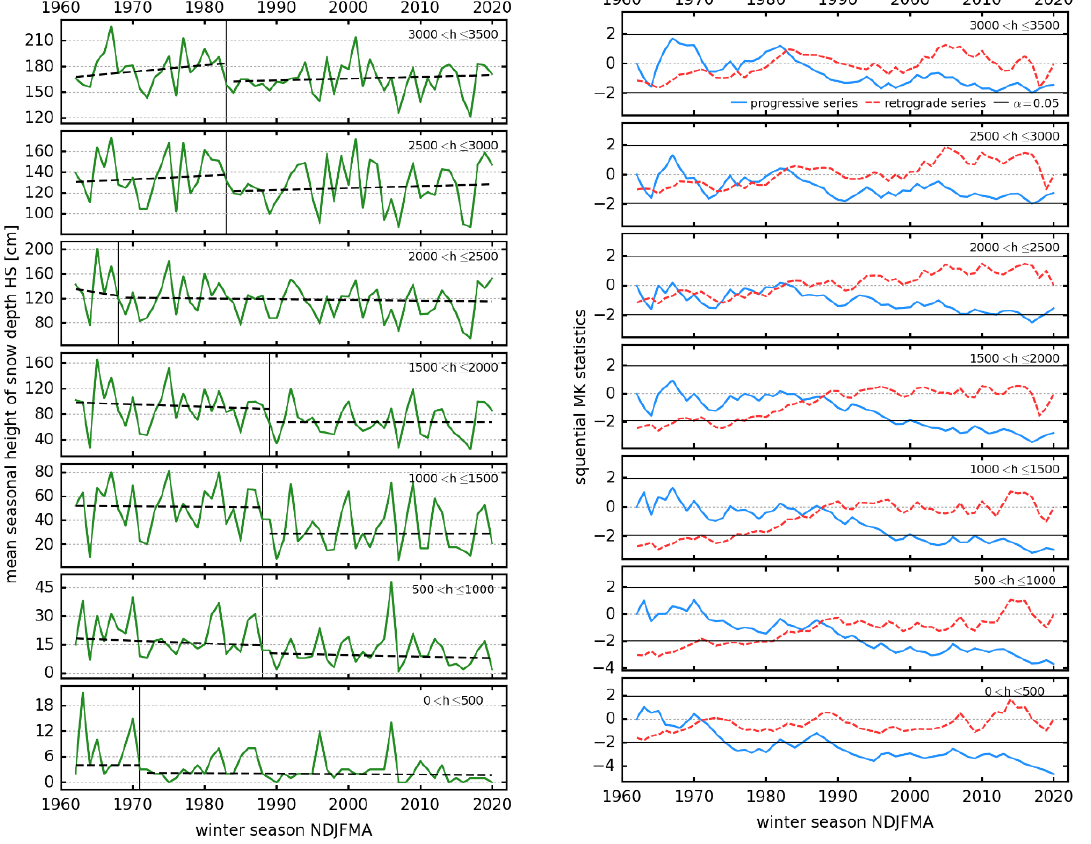
Figure 6. Simulated mean seasonal HS (NDJFMA) in di ff erent elevation ranges ( left ) and results of